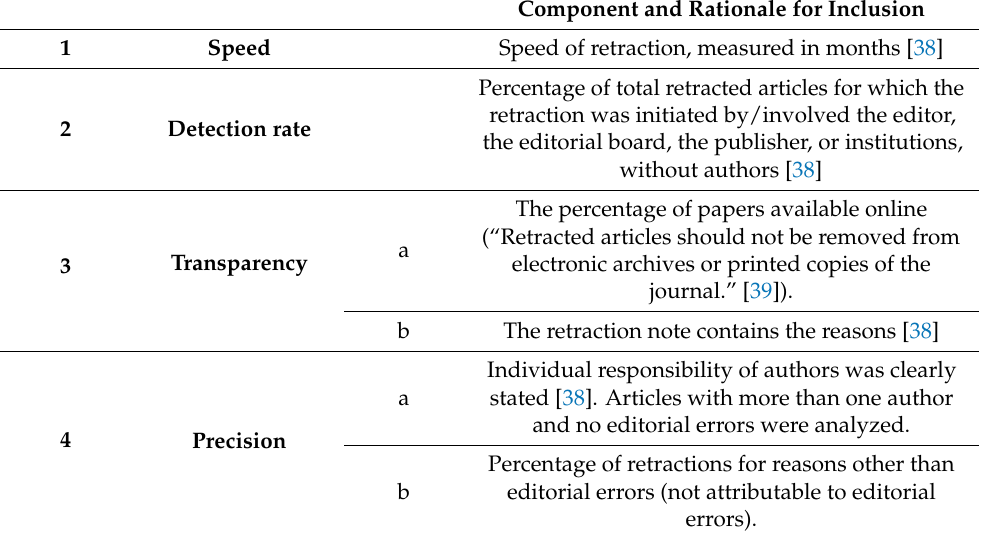
Table 1. SDTP score